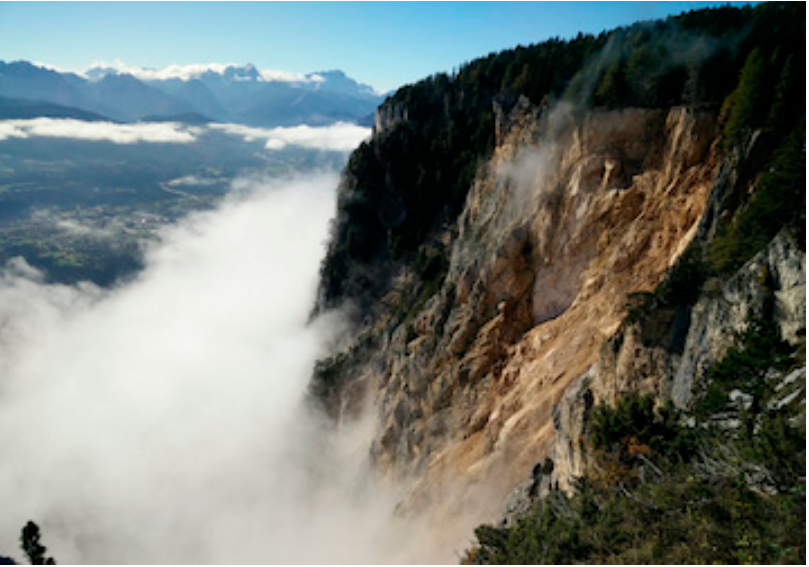
Figure 5. Site of the earthquake and subsequent landslide at Mount Dobratsch as seen from a viewing platform above. The Gail Valley lies below. Photo: Sonja Prendivoj.